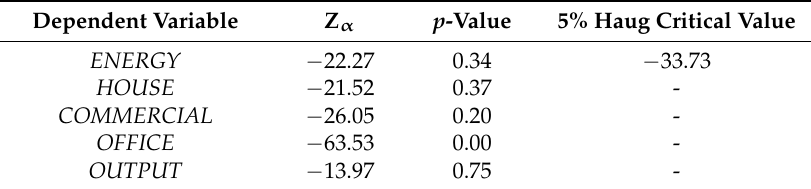
Table 4. The Phillips-Ouliaris cointegration